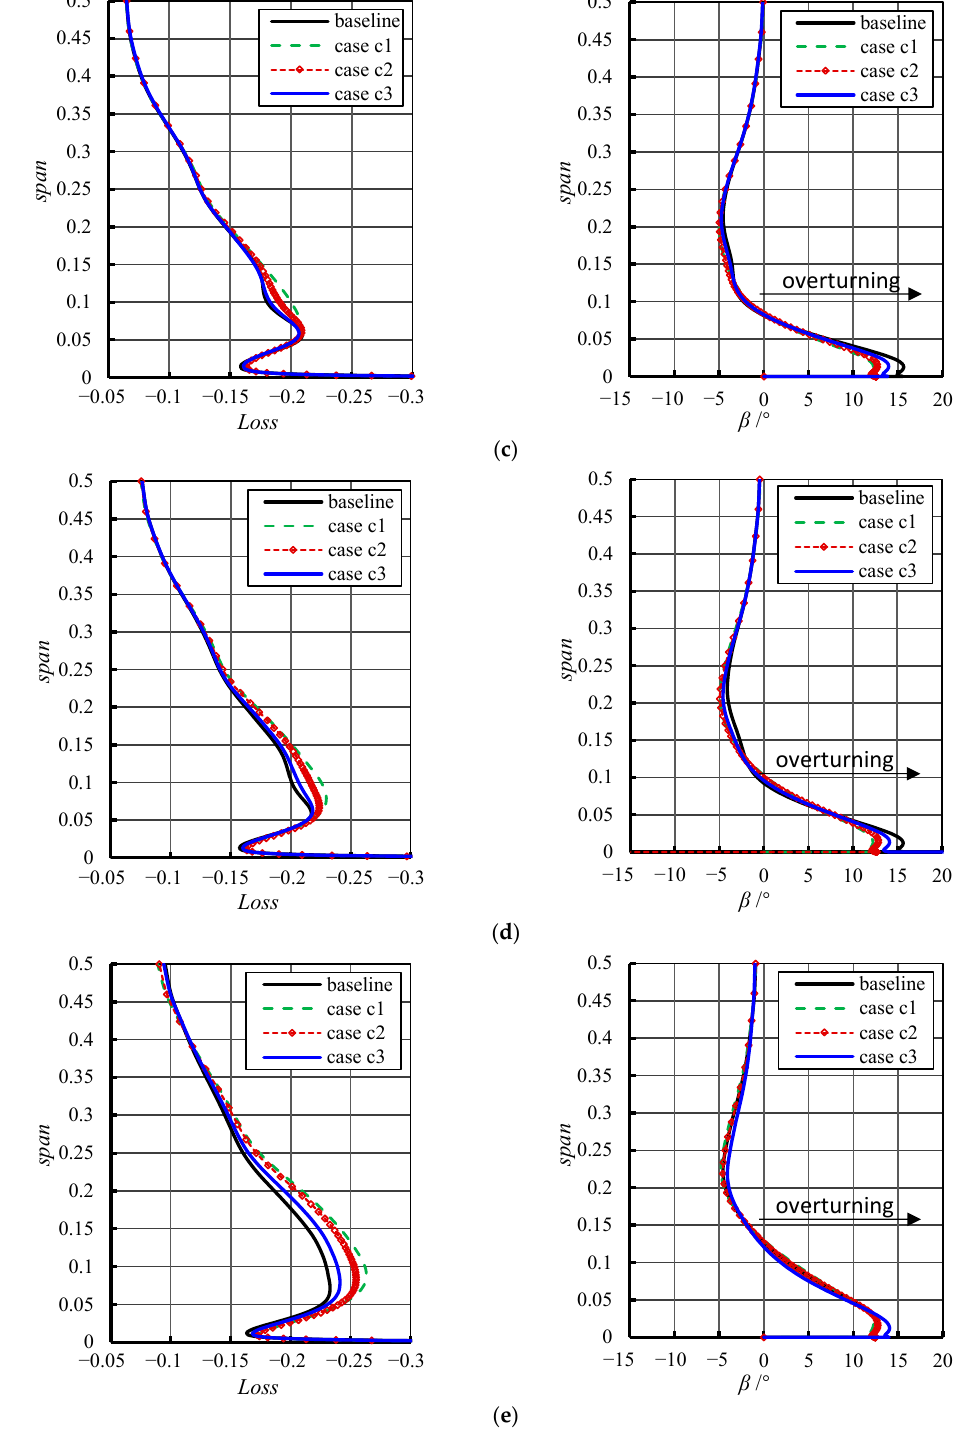
Figure 10. The spanwise distribution of total pressure loss and flow angle at 0.4 C a downstream of the TE. ( a ) i = − 1 ◦ , i.e., the design point; ( b ) i = 1 ◦ ; ( c ) i = 3 ◦ ; ( d ) i = 5 ◦ ; ( e ) i = 7 ◦ , i.e., the near-stall point. As incidence gradually increases, the benefits of end wall contouring at 0.05 span decrease, but the increment of Loss from the 0.08 span to 0.15 span of the end wall contouring cases becomes more significant than the baseline cascade. When the incidence is larger than 3 ◦ , the end wall contouring no longer significantly affects the distribution of Loss at 0.05 span , and the phenomenon continues till the NS point ( i = 7 ◦ ); between 0.08 span